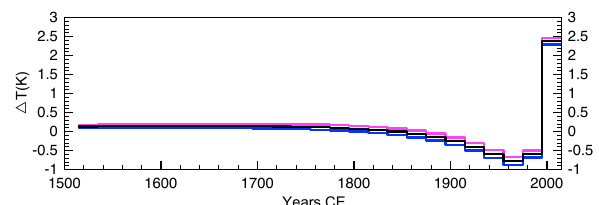
Figure 6. GST history for Inca de Oro determined from the simul- taneous inversion of DDH2457, 1501, 1504, and 1505, with three eigenvalues retained. The pink and blue lines represent the inver- sion of the upper and lower bounds of the temperature anomaly or the extremal steady